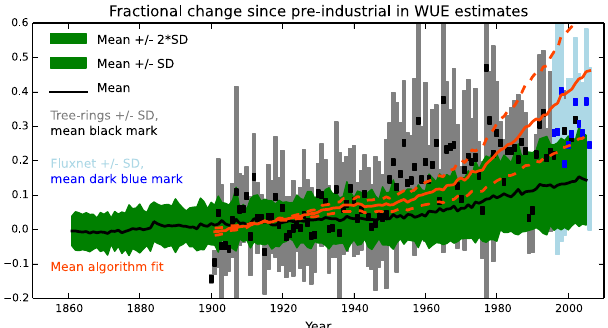
Figure 6. Comparison of measured and modelled fractional changes in WUE from 1860 to 2010. Estimates from tree-rings and eddy covariance data are shown by the black and blue points respectively, with the bars in each case showing ± 1 standard de- viation about the mean response. The results from complex cou- pled Earth System Models are shown by the black continuous line and the green plume (with dark green showing 1 standard deviation and light green showing 2 standard deviations). The algorithm pre- sented in this paper, which estimates fractional WUE changes from changes in CO 2 concentration and humidity deficit alone (Eq. 6), is shown by the orange lines. To enable the comparison between these different estimates, we normalized over common overlapping peri- ods (for the tree-ring data and model simulations – 1900–1930; for the tree-ring and eddy covariance data – the period of overlap when at least three eddy covariance sites are